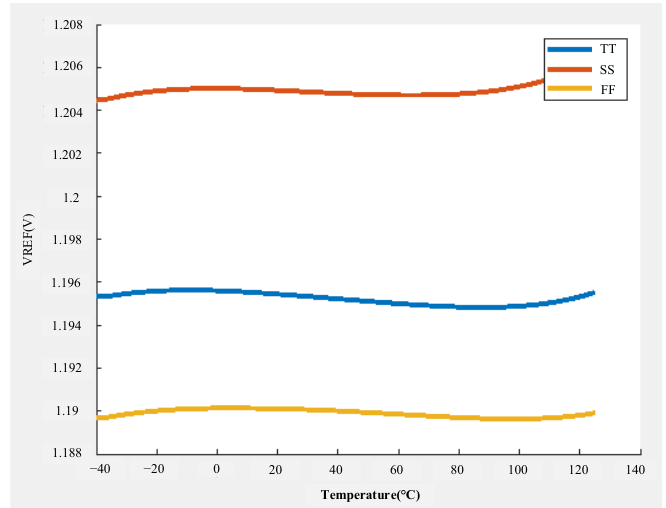
Figure 8. The simulation of process corners for the proposed BGR circuit. The robustness of the proposed BGR circuit is verified by the Monte Carlo analysis. At a normal temperature of 27 ◦ C, the simulation results of Monte Carlo for 200 samples are shown in Figure 9. The average reference voltage is 1.19937 V and the standard deviation is 40.4338 mV with regards to the proposed BGR circuit. Due to the simulation of the 200 samples, how many heterogeneous sample values are affecting robustness is not shown. It is necessary to use the normal quantile plot, which is a basic graphical approach for checking normality. A sample from the normal distribution N ( u ; σ 2 ) can result in a straight line, which is named by x ( i ) = σ z i + u on the normal quantile plot [22]. Any deviation from this line will indicate non-normality. The type of nonlinear pattern may reveal the type of departure from normality. The normal quantile plot results for 200 samples at a normal temperature of 27 °C are shown in Figure 10. The results show that the normal quantile plot successfully extracts a proper straight line. At the same time, most of the sampled result values are distributed around the straight line. Luckily, the sampled values deviate far from the straight line where the number is less than ten. This is an ac- ceptable result, and it indicates that the overall robustness is not bad; however, it still needs improvement. 1.04 1.06 1.08 1.1 1.12 1.14 1.16 1.18 1.2 1.22 1.24 1.26 1.28 1.3 1.32 1.34 1.36 1.38 Values0.05.0 10.0 15.020.025.0 30.0 35.0 40.045.050.0 55.060.0 N o . o f S a m p l e s Number=200 Mean=1.19937 Std Dev=40.4338m Figure 9. The results of the Monte Carlo simulation of the proposed BGR circuit.